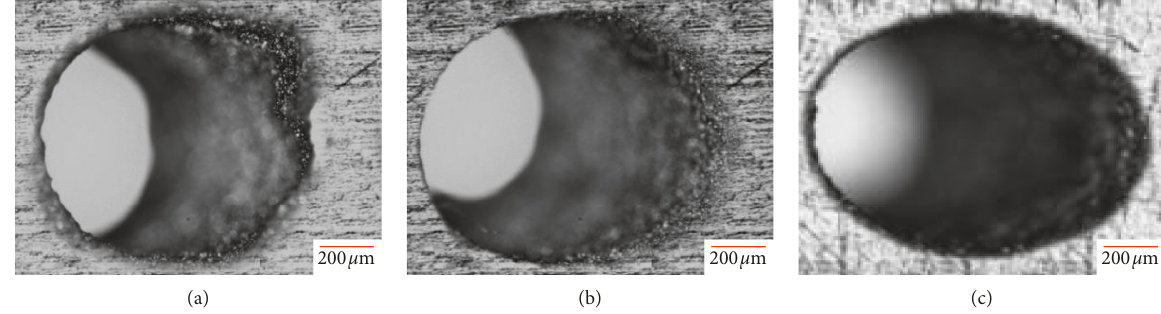
Figure 9: Cooling hole samples machined under different electrolyte concentrations. (a) U � 15 V, ξ � 7% (wt.%). (b) U � 15V, ξ � 11% (wt.%). (c) U � 15V, ξ � 15% (wt.%).